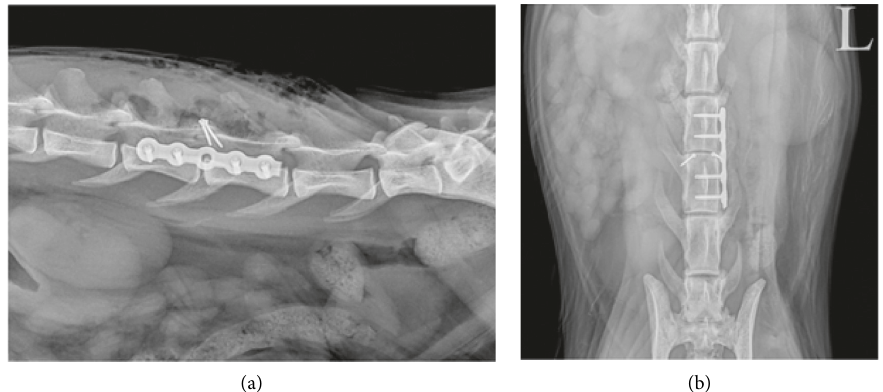
Figure 5: Postoperative lateral (a) and ventrodorsal (b) radiographs of lumbar spine of a cat suffering from L4-L5 injury showing 2-0 UniLock osteosynthesis plate secured with four monocortical titanium locking screws placed on the left side of vertebral bodies of L4 and L5 and two additional 1mm stainless steel facet screws.